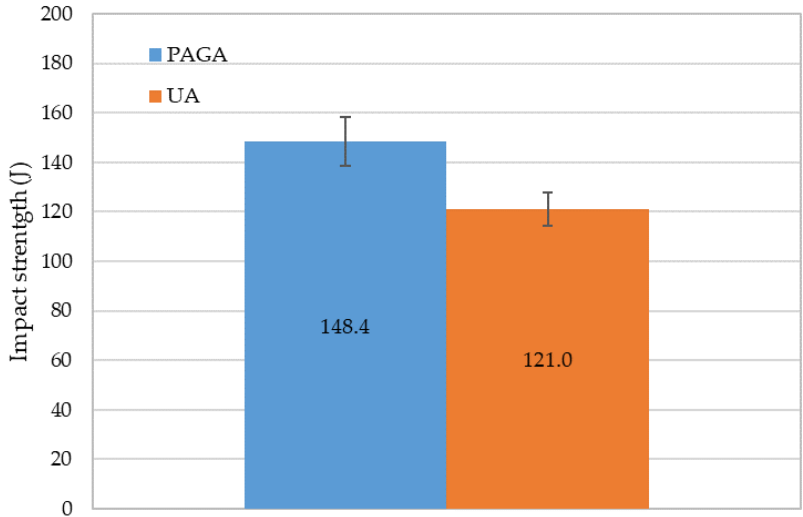
Figure 14. Impact strength of samples manufactured using both powders.